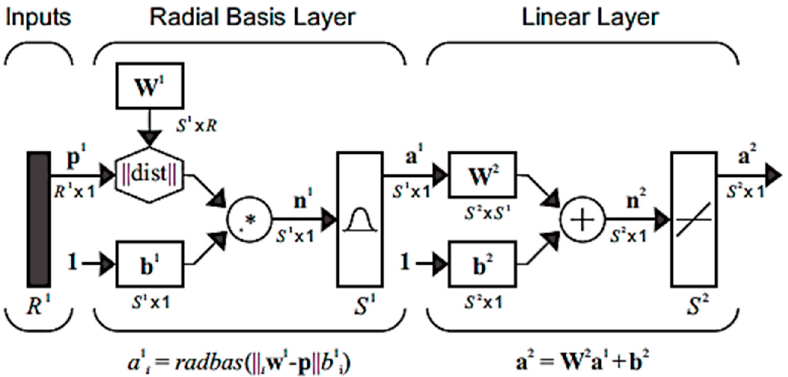
Figure 2. Radial Basis Function Network (RBFN) structure.